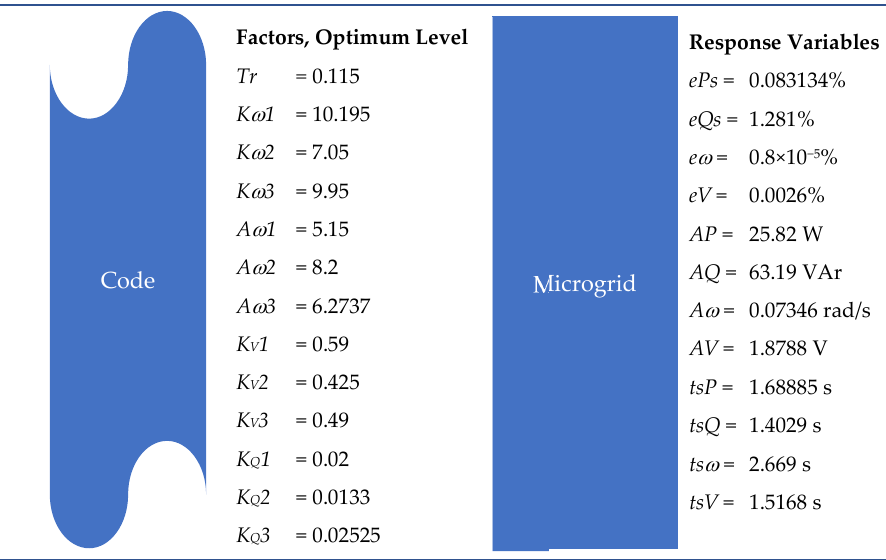
Figure 7. Optimal settings for the parameter tuning.